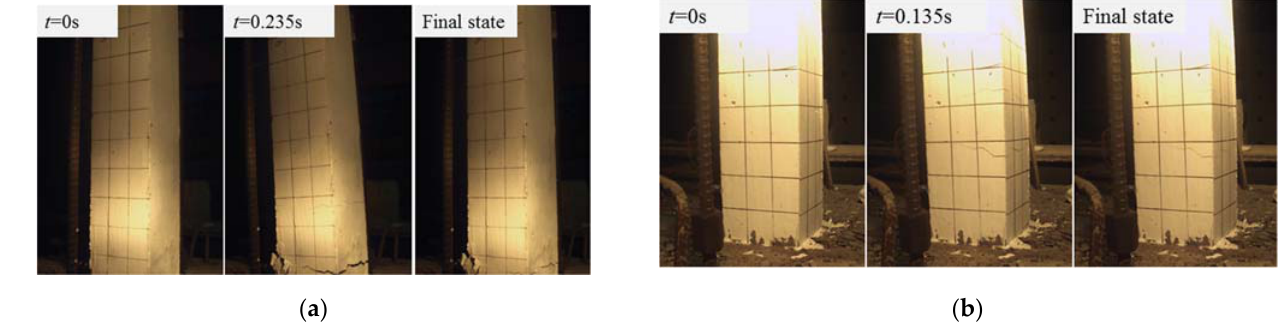
Figure 5. Process of cracking propagation. ( a ) DL120-1.8-0.8; ( b ) DL120-1.2-0.8.